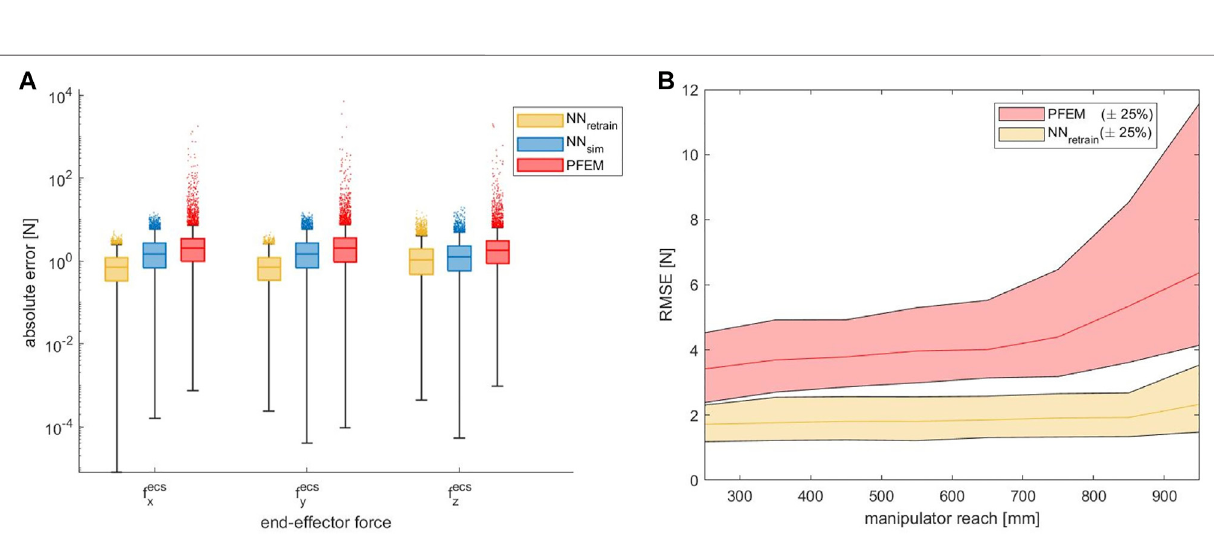
Frontiers in Robotics and AI |